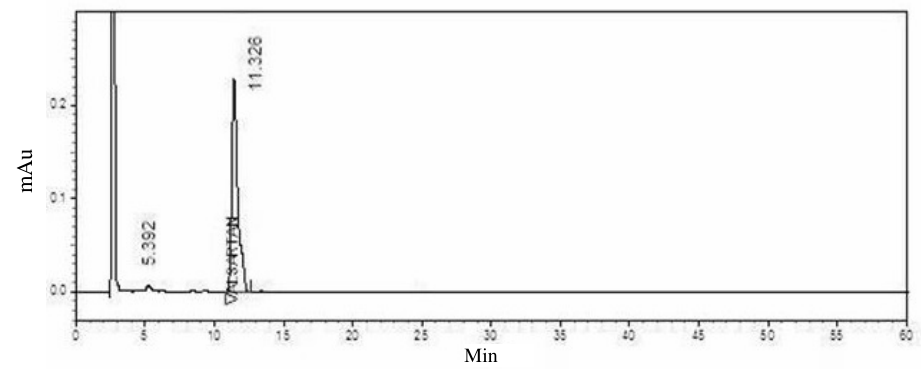
Figure 5. Oxidative degradation of